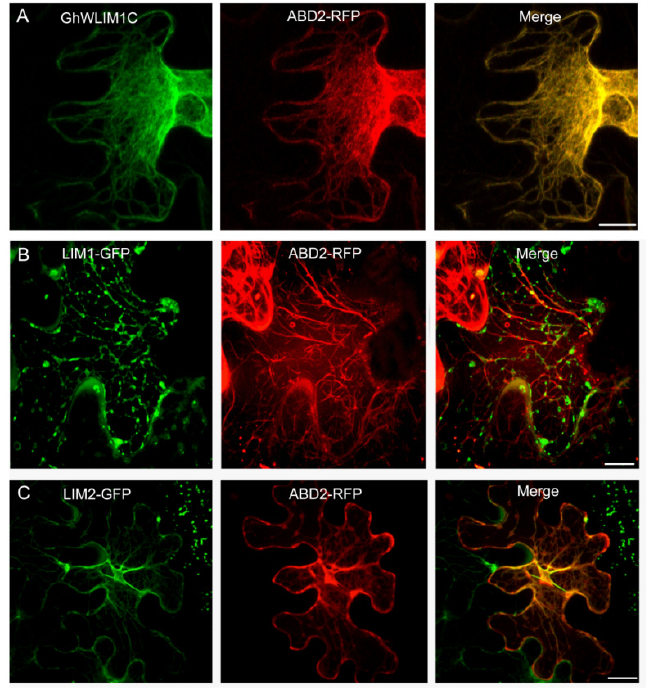
Figure 3. Subcellular localization of GhWLIM1C and its two LIM domains. Colocalization of GhWLIM1C ( A ), LIM1 ( B ), LIM2 ( C ). and ABD2-RFP in the N. benthamiana cells. Agrobacterium cells containing the indicated pair of GhWLIM1C-GFP, LIM1-GFP, LIM2-GFP, and ABD2-RFP plasmids were coinfiltrated into leaves of N. benthamiana . The signal was visualized by confocal microscopy. Bars = 20 µm.